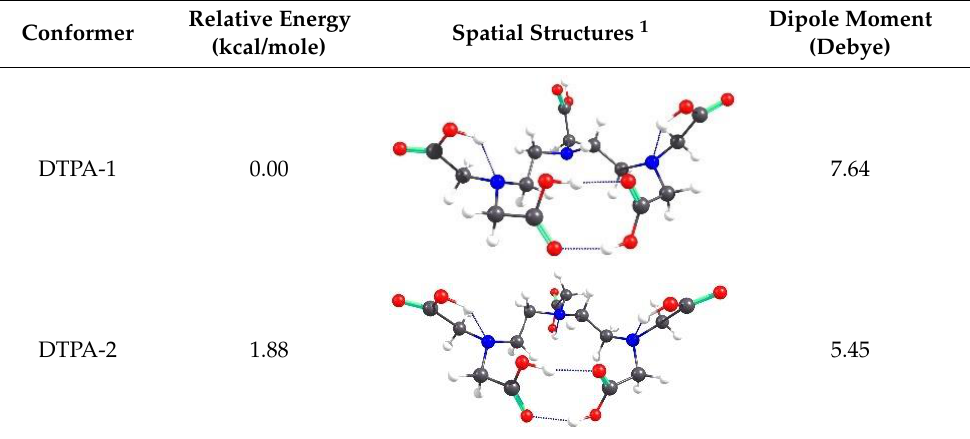
Figure 8. The variation of the relative energy considering the values of the dihedral angle N-C-C-N. Compared to EDTA, the structure of DTPA is more complex, having an additional aminocarboxylic fragment inserted into the main chain (Figure 1A). The conformer of DTPA with the lowest energy has been also determined by applying similar calculations as in the case of EDTA structure. In Table 5, the top five conformer structures of DTPA have been selected with respect to their relative energy. Table 5. Conformers of DTPA.